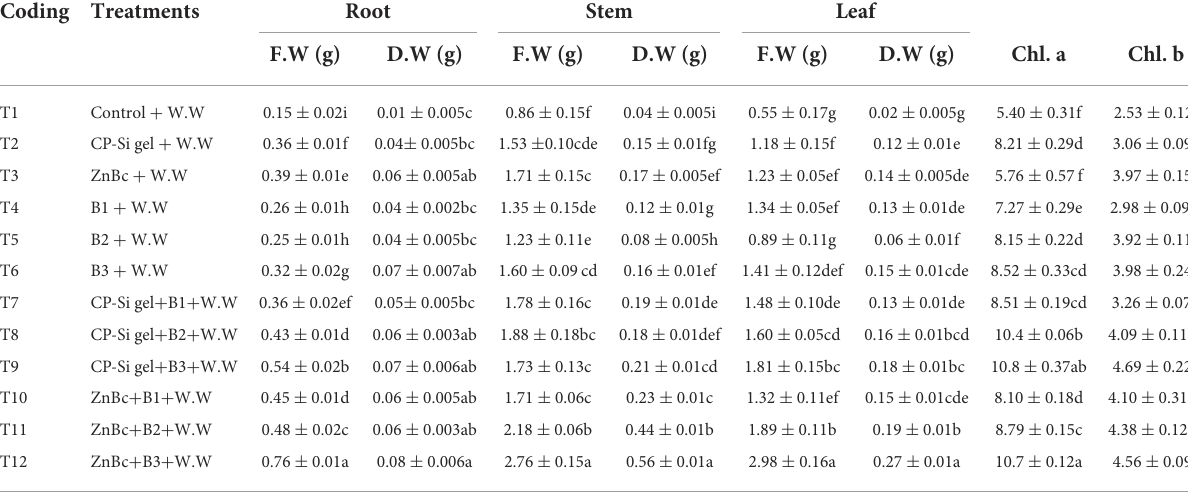
TABLE 3 Fresh and dry weight of root, stem, and leaf, and leaf chlorophyll content of Solanum melongena L. plant determined after harvesting under different treatments against heavy metal stress. Coding